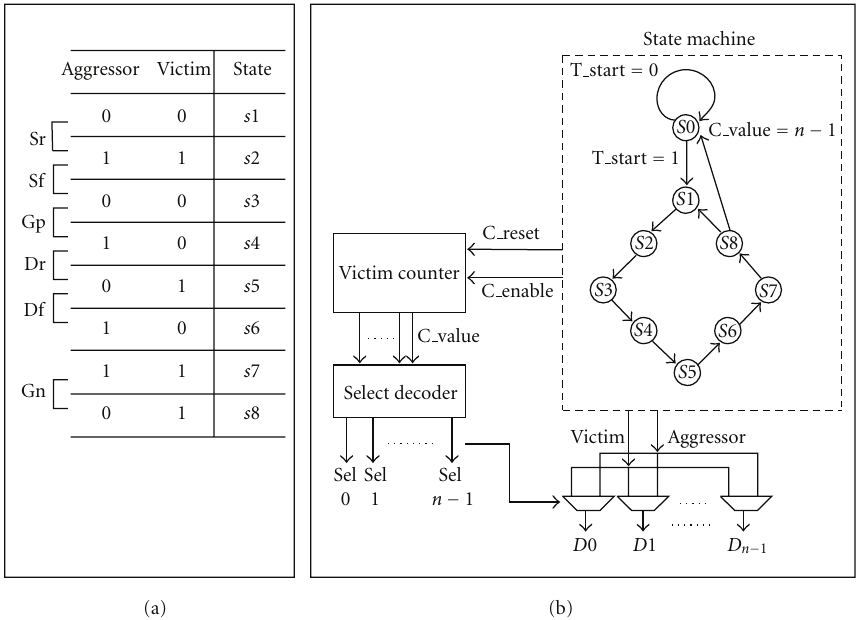
Figure 13: MAF-based test pattern generator (a) 8 states complete 6 faults test of MAF model. (b) Hardware